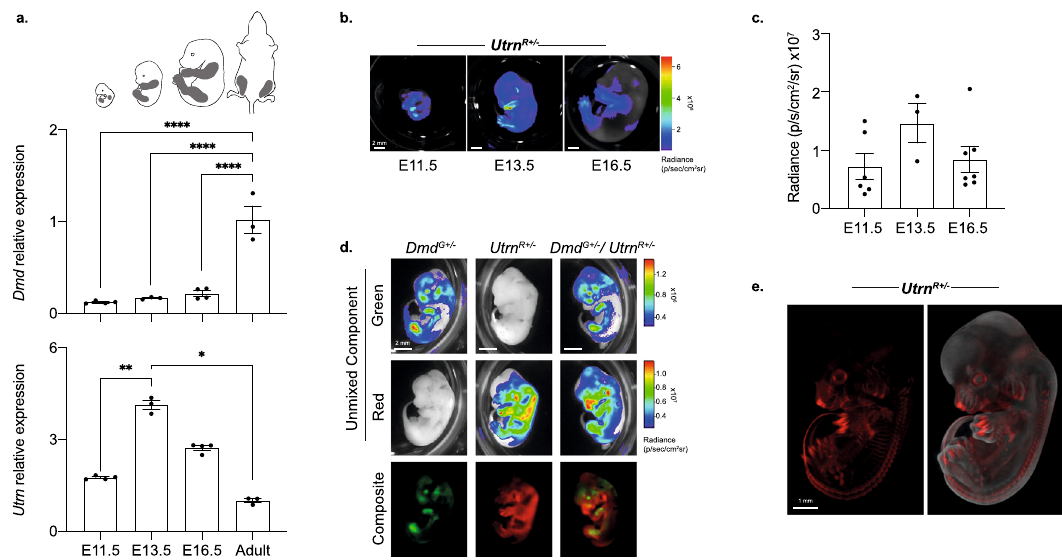
Fig. 3 Dmd and Utrn expression during mouse ontogeny. a RT-qPCR analysis of Dmd (upper panel) and Utrn (lower panel) mRNA expression in limb tissue during mouse development. Sampled as highlighted in grey. Expression levels were normalised to 18 S and Tbp . Bars show mean + / − SEM; comparison between ages was performed using a one-way ANOVA ( p < 0.0001 for Dmd and p = 0.008 for Utrn ) with Tukey ’ s multiple comparisons test (adjusted p values are shown: * p < 0.05, *** p < 0.001, **** p < 0.0001). b , c Representative bioluminescent images ( b ) and quanti fi cation ( c ) of limb radiance from Utrn R + / − embryos sampled during embryogenesis. d Spectral unmixing of Dmd G + / − , Utrn R + / − and Dmd G + / − / Utrn R + / − E13.5 embryos. The green component (representing CBG99Luc) was only detected in Dmd G + / − and Dmd G + / − / Utrn R + / − embryos, while the red component (representing RFluc) was detected in Utrn R + / − and Dmd G + / − / Utrn R + / − embryos. e X-Gal staining of lacZ expression in Utrn R + / − E13.5 embryo, visualised by optical projection tomograph (OPT). LacZ signal is shown in red with total body fl uorescence, used to visualise mass, shown in grey. LacZ signal was strongest in the developing digits and